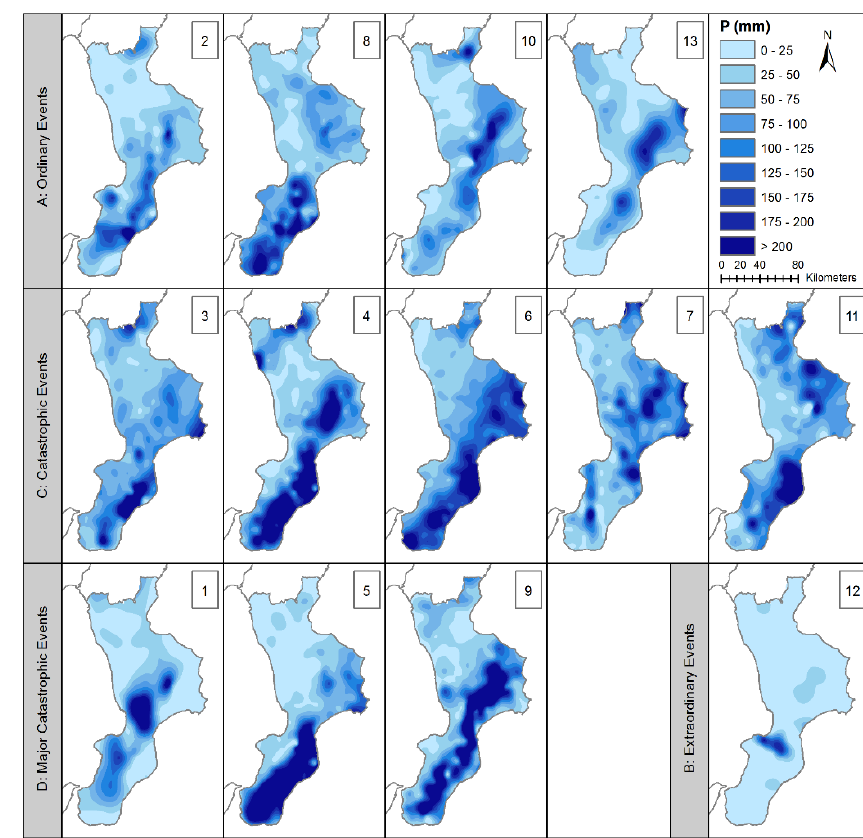
Figure 5. Maps of the daily rainfall recorded during the events. Numbers from 1 to 12 are the same as in Table